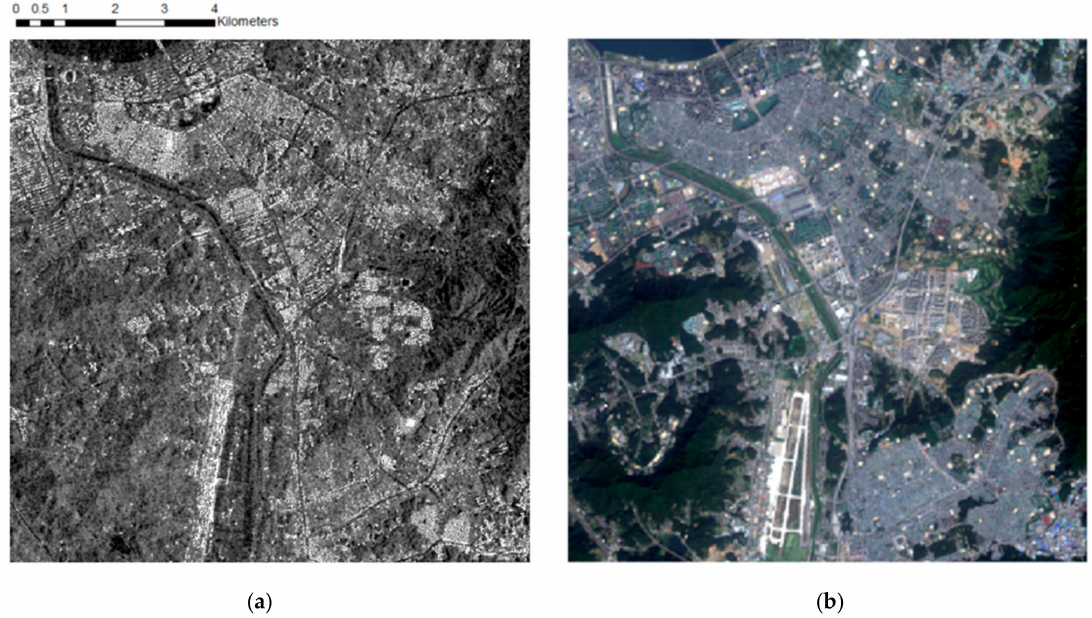
Figure 3. Experimental area of Site 1: ( a ) KOMPSAT-5 image acquired on 21 August 2014. ( b ) reference Landsat-8 OLI image acquired on 24 September 2016.